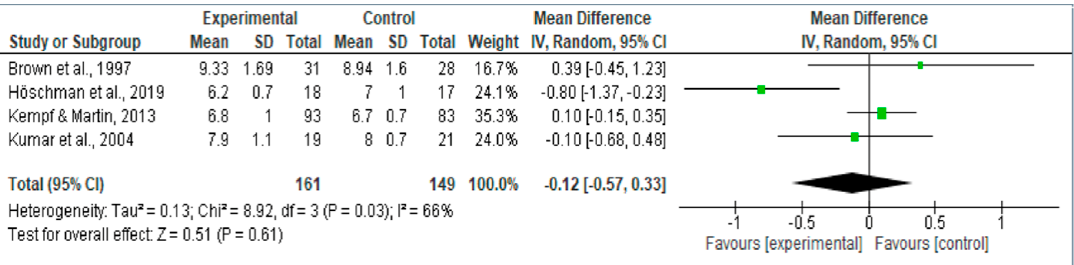
Figure 2. Forestplot of the effect size of games and gamification for glycated hemoglobin (HbA1c) reduction in people with diabetes.